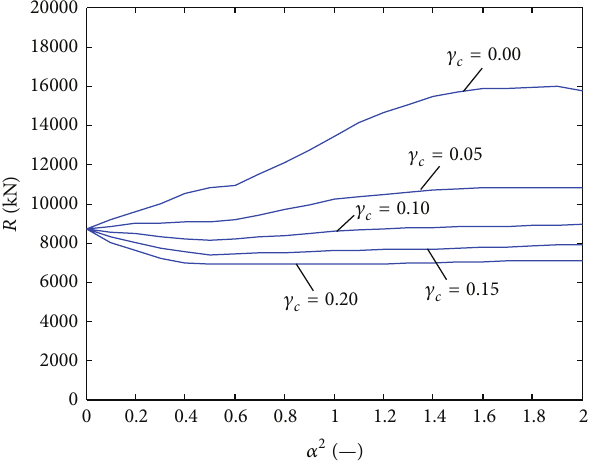
Figure 9: Variation with 𝛼 2 of total base shear 𝑅 for different values of 𝛾 𝑐 .